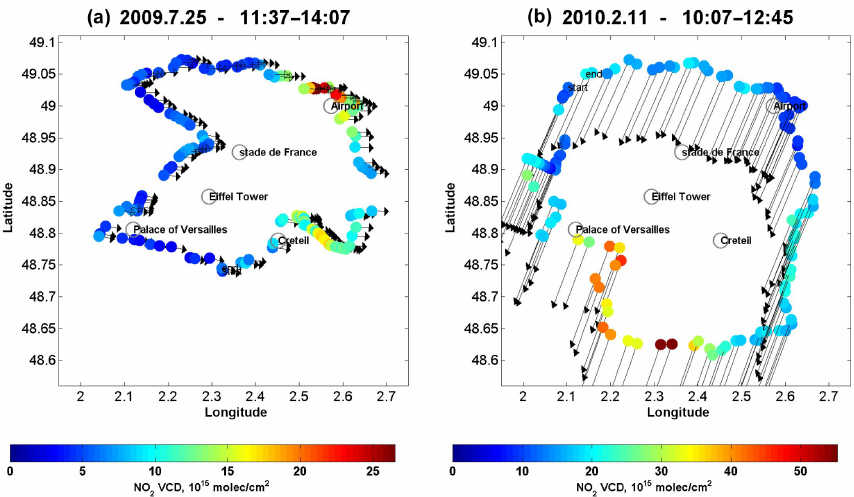
Figure 7. Measured NO 2 VCDs and corresponding wind vectors for 2 selected days with extreme lifetime correction factors. Dates are given as yyyy.m.dd. For the day with low wind speed (a) , a high lifetime correction factor of 1.71 is found, and for the day with high wind speed (b) , a low lifetime correction factor of 1.05 is